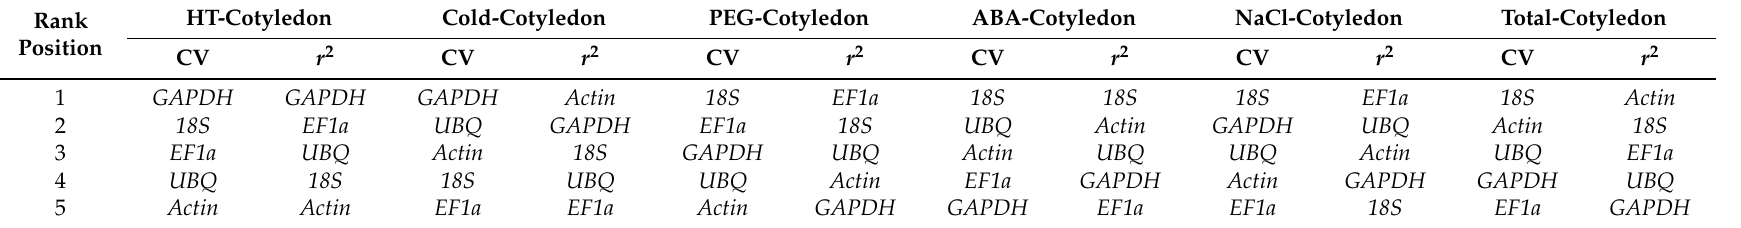
Table 4. Expression stability values and ranking of HKGs in Chinese fir cotyledon as calculated by